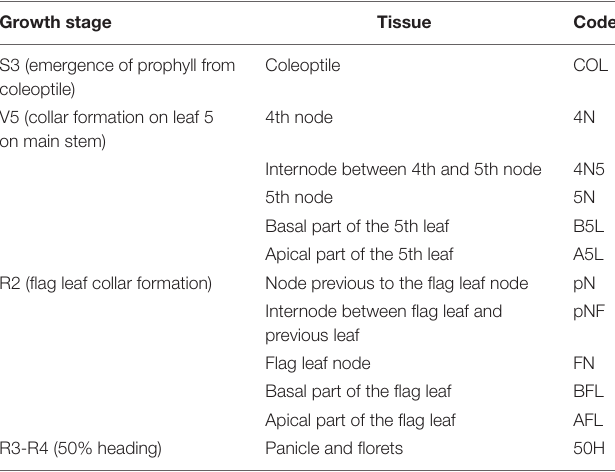
TABLE 1 | Growth stages, according to the rice development system proposed by Counce et al. (2000), used for sample collection of the plants grown in the